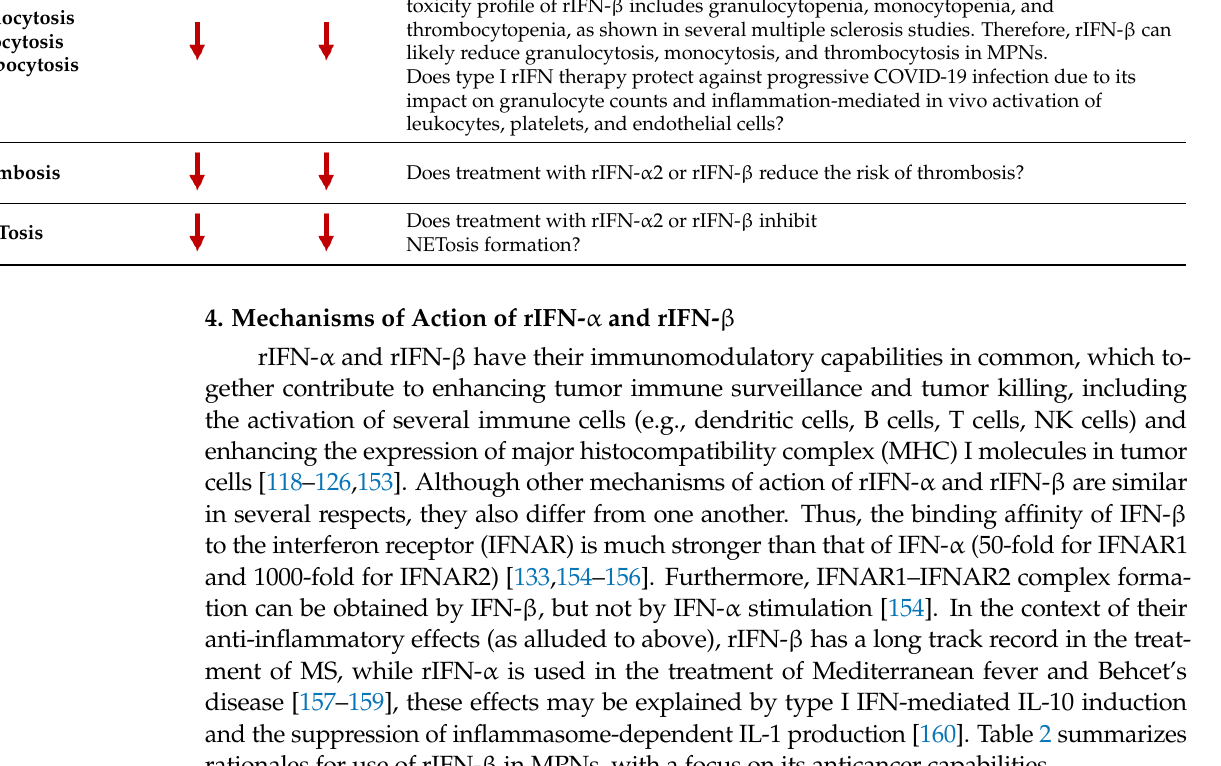
Table 1. Some key questions with regard to the impact of rIFN- α2 and rIFN - β on clinical, biochem- ical, and immunological markers in MPNs.